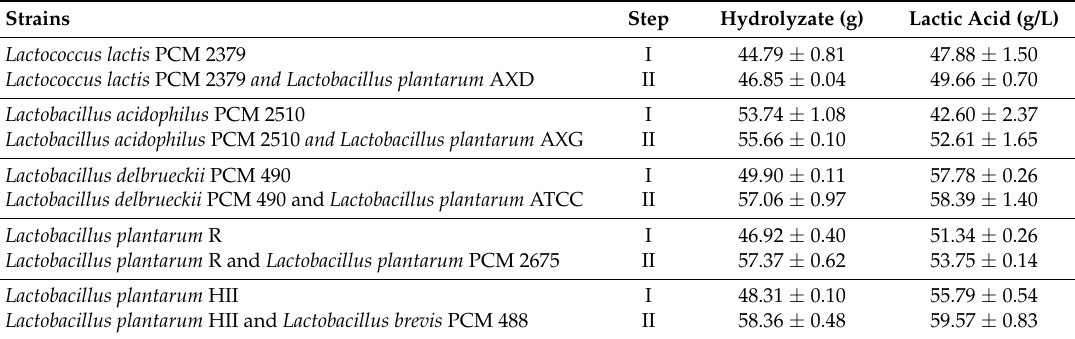
Table 4. Effectiveness of hydrolysis and lactic acid fermentation of sugar beet pulp in SSF processes conducted with monocultures (step I) and mixed cultures (step II). Experiment started after 10 h of enzymatic pretreatment.